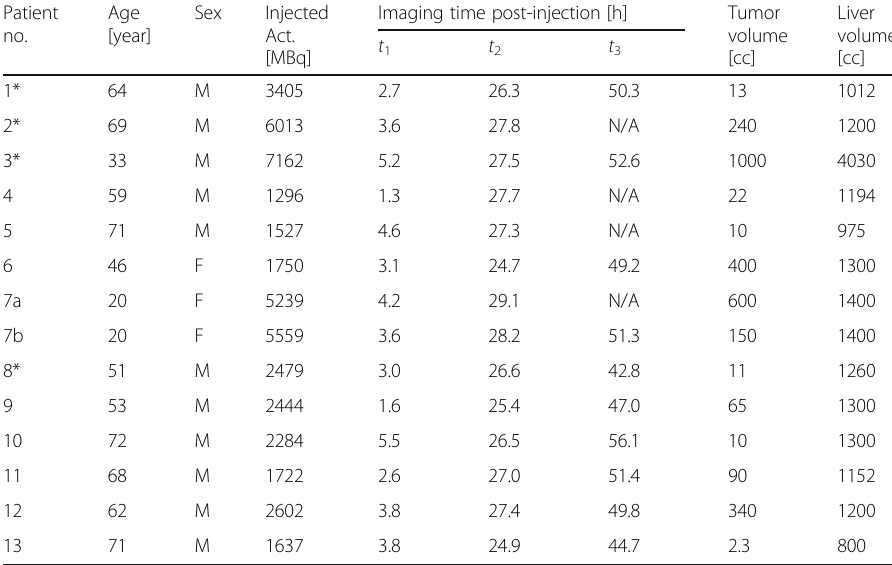
Table 1 Patient information. The reported administered activities correspond to the dose- calibrator readings corrected for Lipiodol attenuation. The liver volumes were derived from pre-treatment contrast-enhanced CT images except for patients 3 and 8, which were derived from post-treatment SPECT/CT images Patient Injected no.